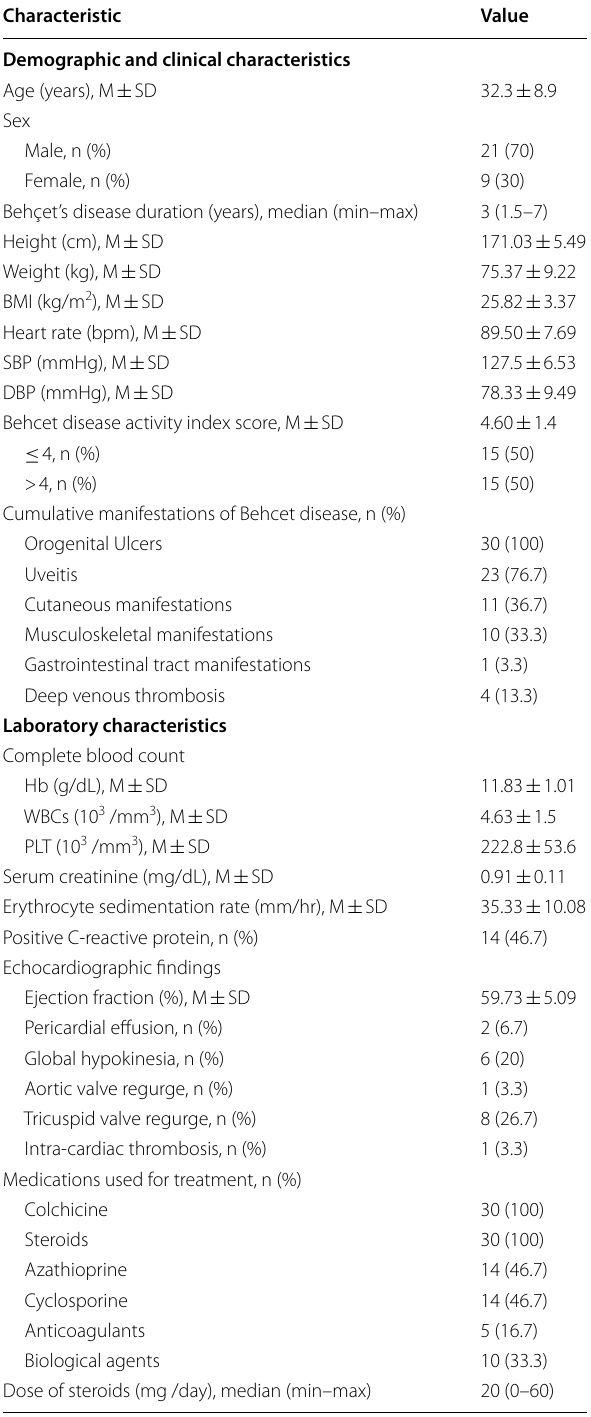
Table 1 Demographic, clinical, laboratory, echocardiographic and treatment characteristics of patients (n